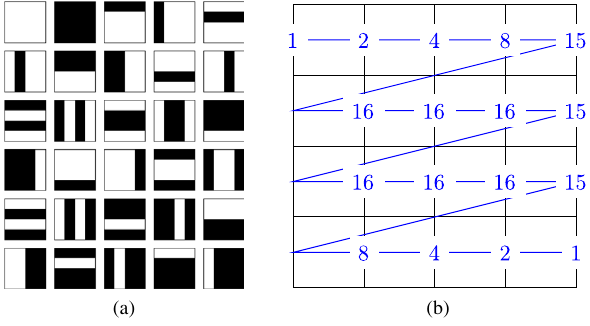
FIG. 1. (a) The Bars and Stripes data set. (b) Ordering of the pixels when transforming the image into a one-dimensional vector. The numbers between pixels indicate the bond dimensions of the well-trained MPS.